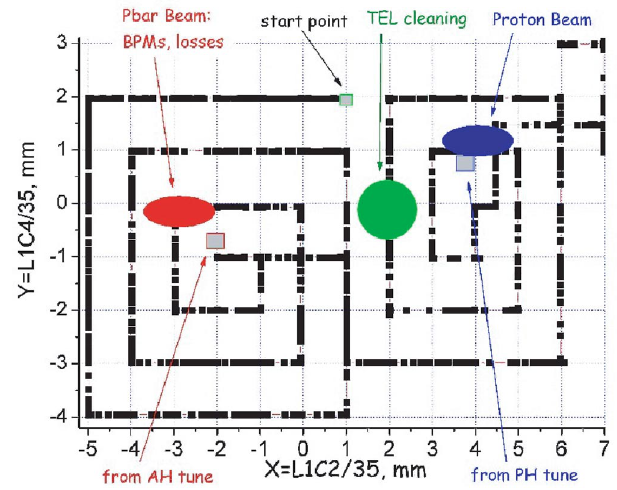
FIG. 84. (Color) Summary of TEL position scan; beam sizes are approximately to scale (Shiltsev)